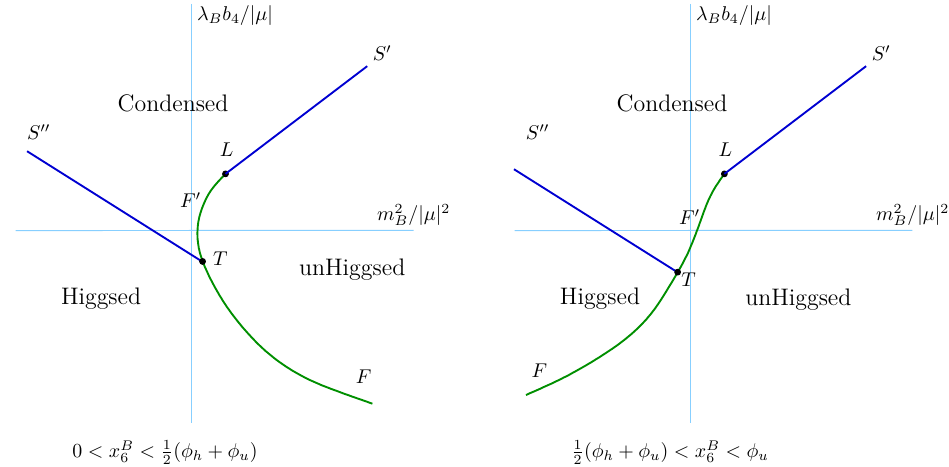
Figure 16 . Phase diagram for 0 < x B < φ u . We have restored the | µ | dependence of the phase 6 diagram by rescaling m 2 and λ B b 4 by appropriate powers of | µ | . The blue lines are second order B transitions and the green line is a first order transition. The figure on the left is for the range 0 < x B < 1 ( φ h + φ u ) where the first order line goes to infinity in the fourth quadrant. The figure 6 2 on the right corresponds to 1 ( φ h + φ u ) < x B < φ u where the first order line goes to infinity in the 6 2 third quadrant. At the special value x B = 1 ( φ h + φ u ) the green first order phase transition line 6 2 from T downwards runs down the λ B b 4